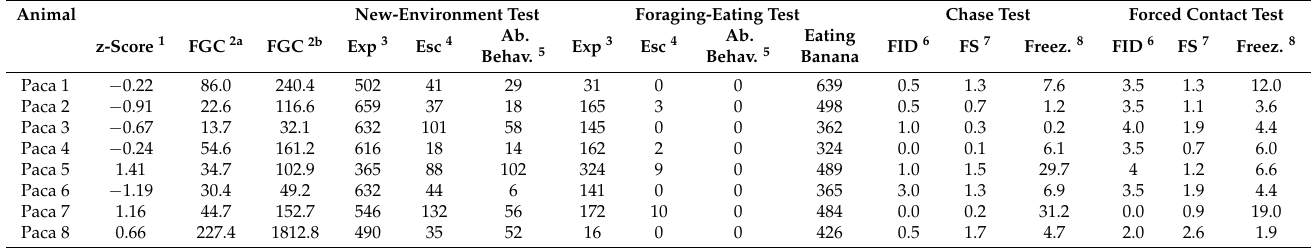
Table 5. The relationship between “restless” temperament scores and modified defence test battery (MDTB) behaviours and faecal glucocorticoid metabolites. Animal New-Environment